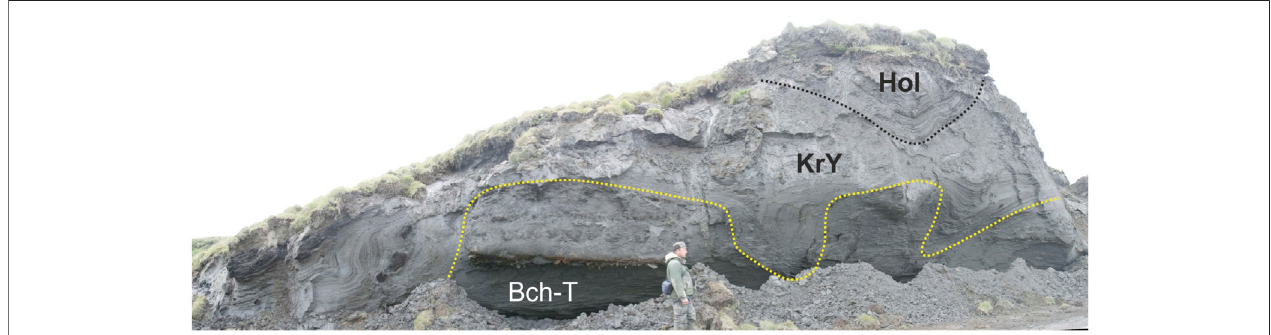
FIGURE 9 | Krest-Yuryakh Suite deposits (KrY) form ice-wedge casts as the result of Bychchagy Ice Complex thawing. In this section (Oyogos Yar), there are taberal Bychchagy Ice Complex (Bch-T) deposits with a thawed peat lens and the Holocene ice-wedge cast (Hol) as a result of yedoma Ice Complex thawing.